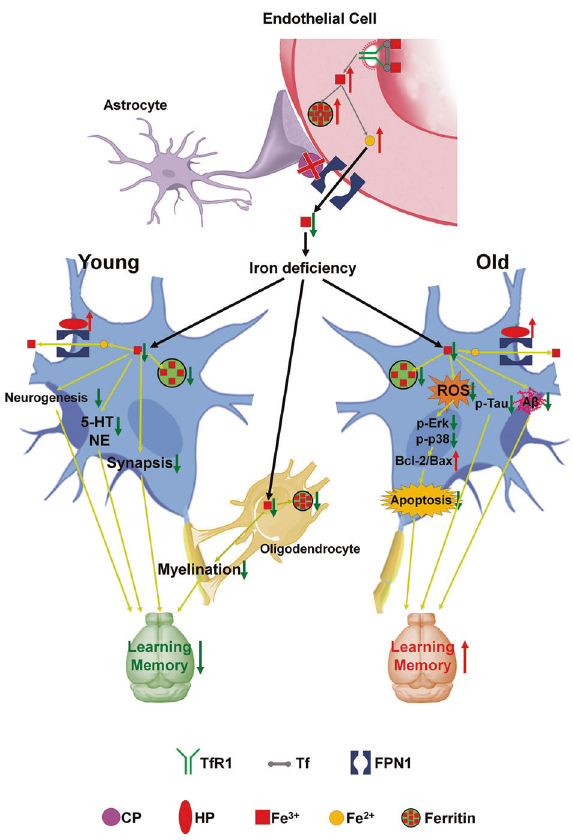
Fig. 8 A schematic diagram of the proposed divergent effects of astrocyte-speci fi c Cp knockout on learning and memory function. Astrocyte-speci fi c Cp knockout blocks iron in fl ux FPN1-CP pathway into the brain, leading to iron de fi ciency, decreased ferritin in neurons and oligodendrocytes, and increased iron levels in BMVECs of Cp Gfap cKO mice. Moreover, HP expression of neurons was up- regulated, enhancing the iron export from neurons and the iron de fi ciency of neuron. In young (6 M) Cp Gfap cKO mice, Iron de fi ciency can lead to abnormal adult hippocampal neurogenesis, synaptic formation, myelination and decreased 5-HT and NE synthesis. Finally, learning and memory dysfunction come into being. While in old (18 M) Cp Gfap cKO mice, iron accumulation with aging is attenuated. Thus, the level of oxidative stress is decreased, the MAPK (Erk/p38 phosphorylation, p-p38 and p-Erk) signaling activation is altered and the level of apoptosis is diminished. Besides, AD-like pathologies such as A β aggregation and Tau phosphorylation are also decreased, which may result from down-regulated iron contents. The decreased oxidative stress-induced apoptosis and hallmarks of AD may make the abilities of learning and memory improved at the old